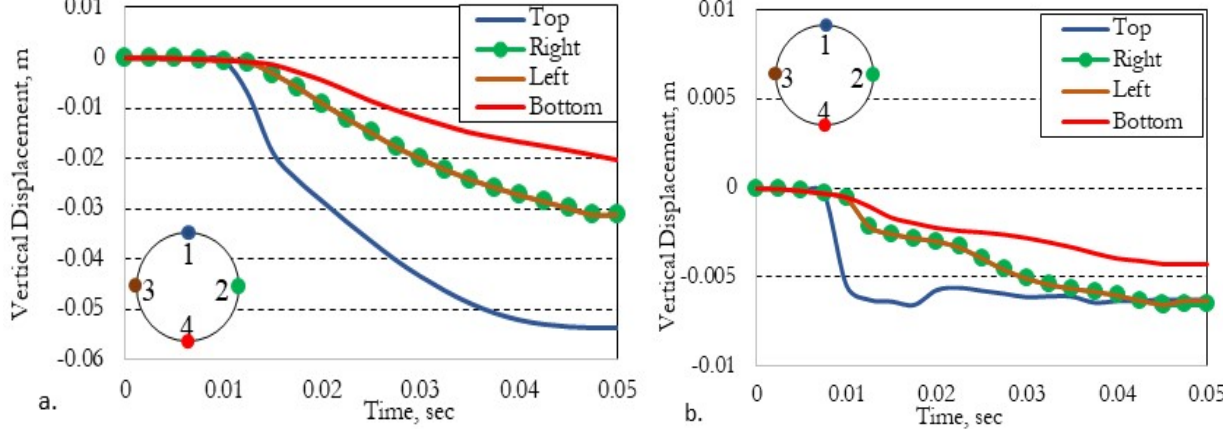
Figure 13: a. Displacement with time for soil (A). b. Displacement with time for soil (A).